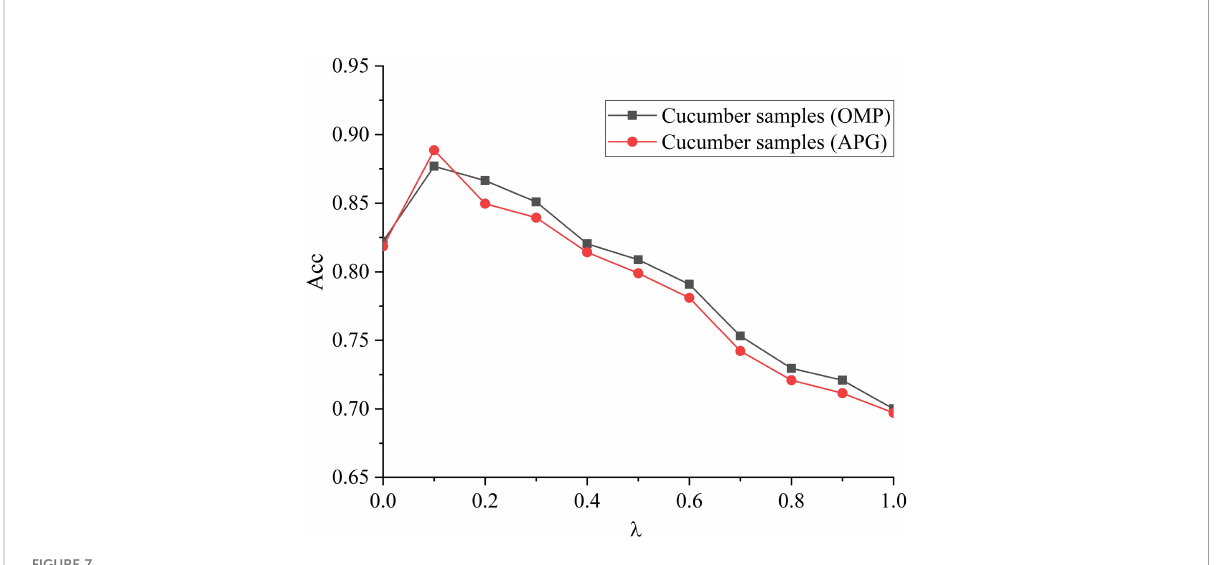
FIGURE 7 In fl uence of regularization parameters on recognition